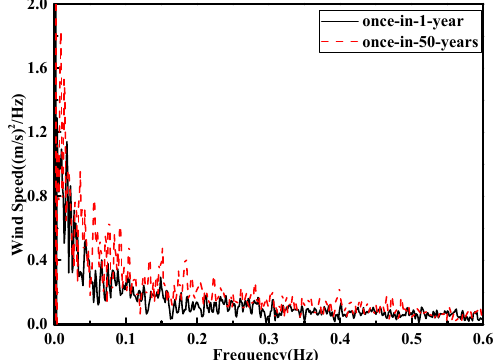
Figure 13. Power spectra of wind speed.